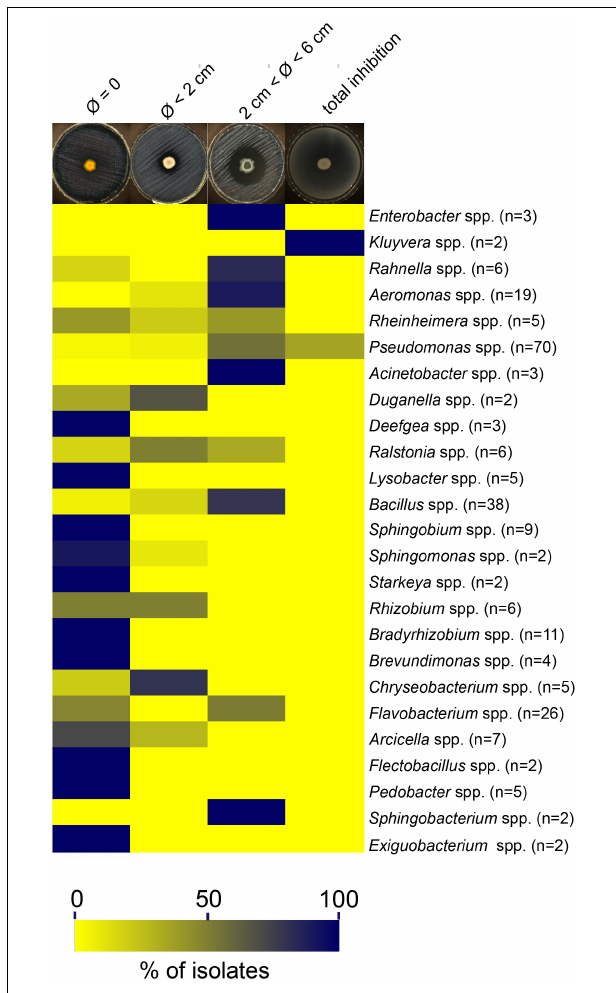
FIGURE 4 | Distribution of inhibition diameters among bacterial genera. The heatmap was constructed using relative abundance of each inhibition profile among all genera. The letter “n” corresponds to the total number of bacterial isolates for a given genus. Genera represented by only one isolate are not included in this heatmap and are detailed in Table 1 .